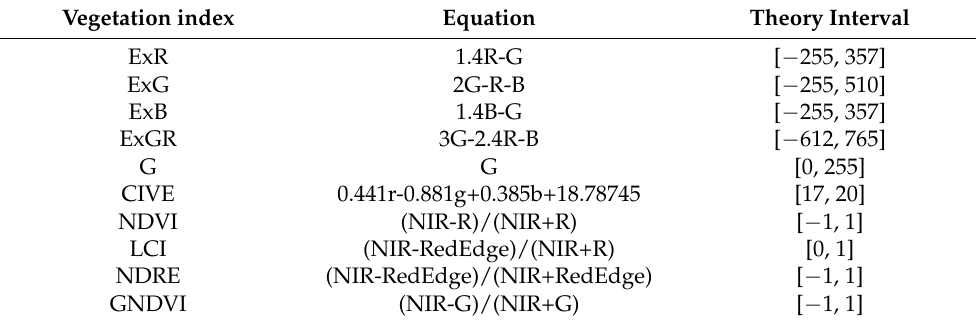
Table 2. Vegetation indices based on visible